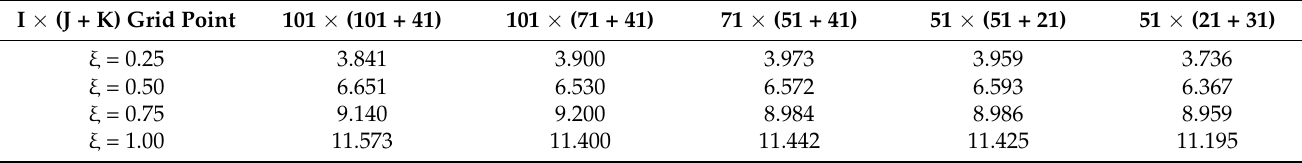
Table 1. Stability of calculation in mesh variations local water film evaporation rate.